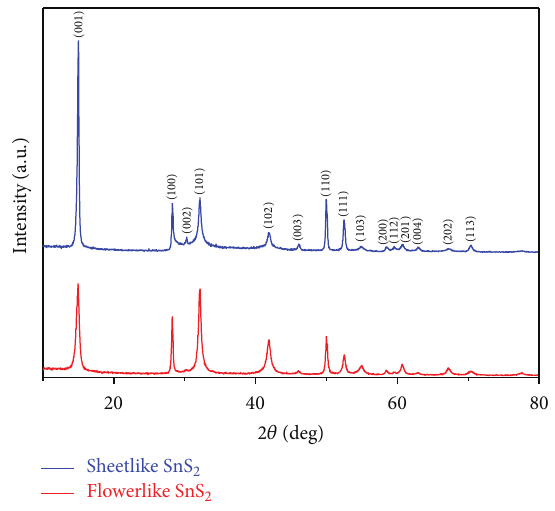
Figure 1: XRD patterns of the SnS 2 samples.